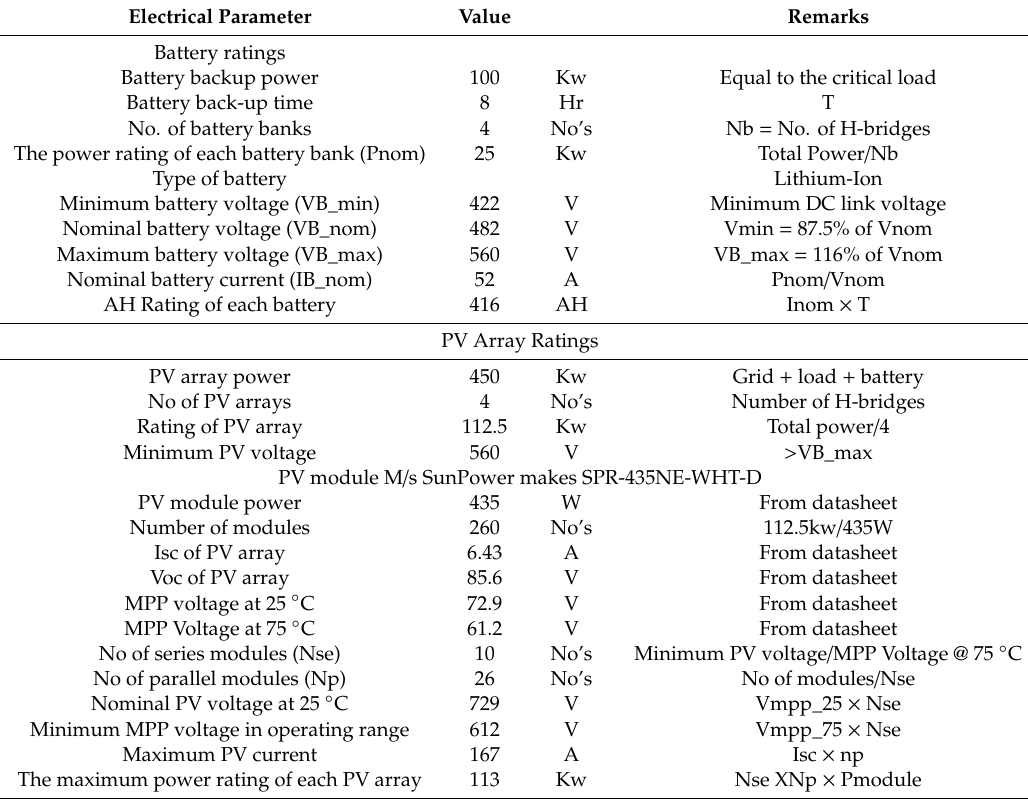
Table 2. Selection of battery and PV